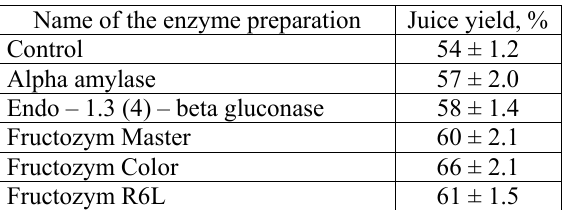
Table 3. Juice yield from the pulp of Nantes